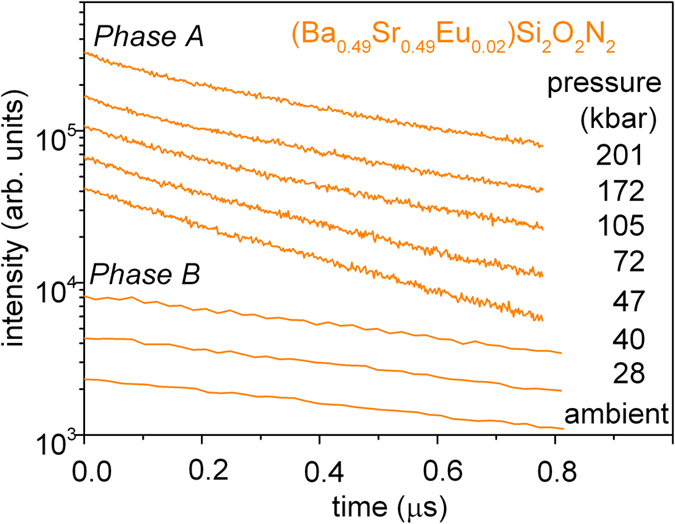
PL decays of the (Sr0.49Ba0.49Eu0.02)Si2O2N2 for different pressures collected at maximum of luminescence under excitation of 442 nm.